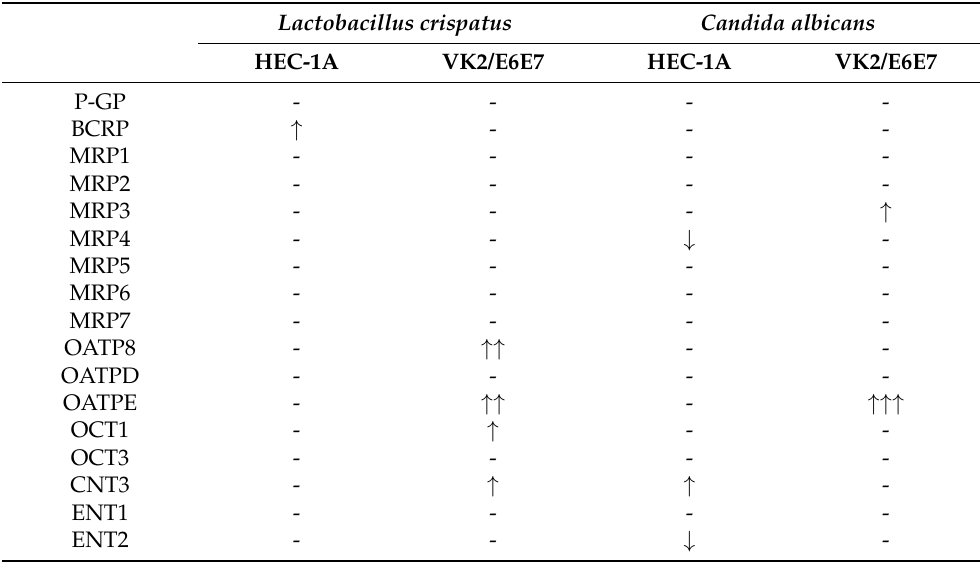
Table 3. A summary of changes in drug transporter mRNA expression in HEC-1A cell and VK2/E6E7 cells upon 24 h co-culture with Lactobacillus crispatus or Candida albicans